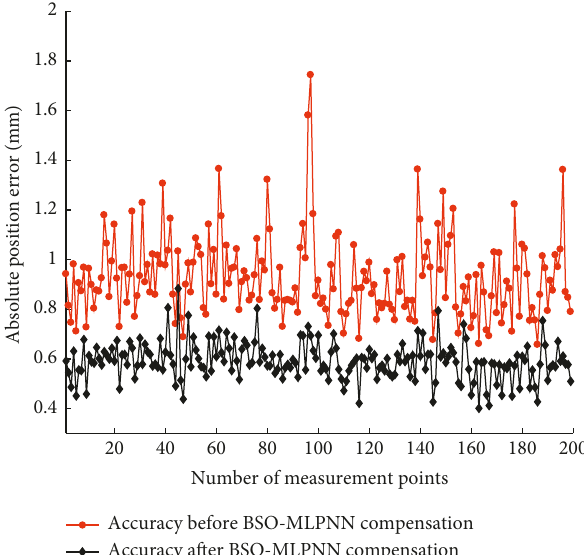
Figure 8: Absolute positioning accuracy before and after nongeometric compensation of measurement points.